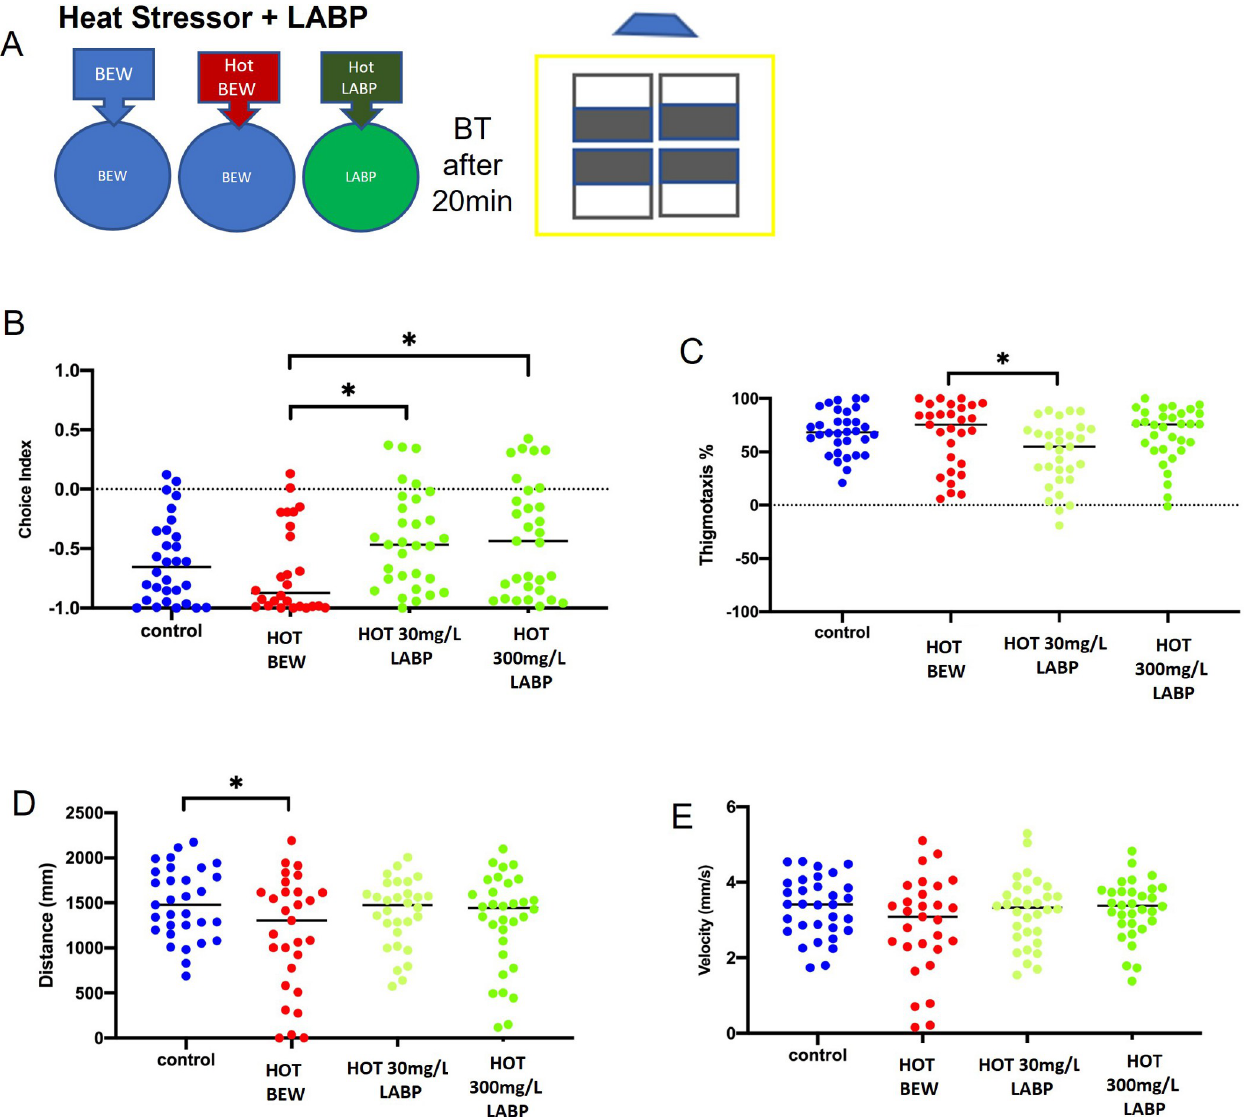
Fig 5. Behavior effects after heat stressor and LABP exposure. A. The schematic of the behavior test after the addition of a heat stressor + LABP exposure. B. 30 and 300 mg/L of hot LABP significantly increased the choice index when compared to hot BEW (p = 0.0473 and p = 0.0348, respectively). C. 30 mg/L of hot LABP significantly decreased the thigmotaxis when compared to hot BEW (p = 0.0314). D. There was a significant difference in distance between BEW at room temperature and hot BEW (p = 0.0334). E. There was no significant difference in velocity between the groups. Asterisks indicate statistical differences between groups ( � p < 0.05). n =